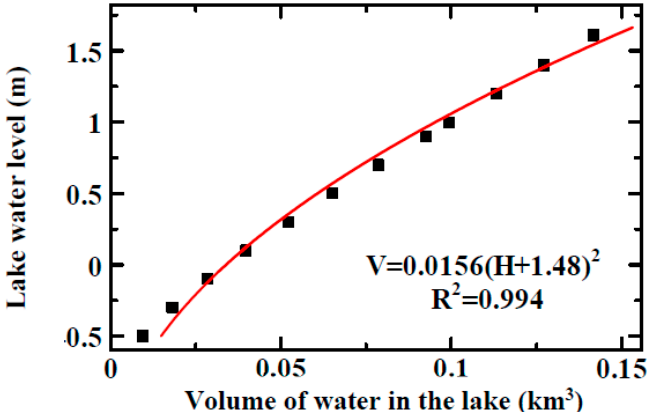
Figure 8. The relationship between volume and water